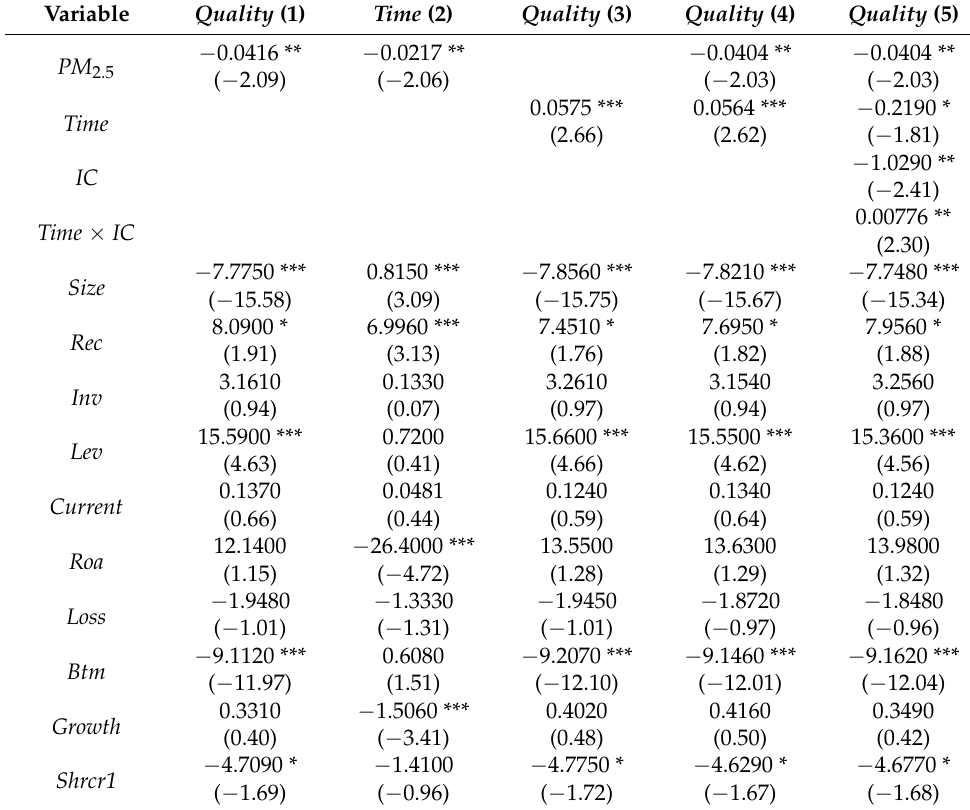
Table 3. Regression